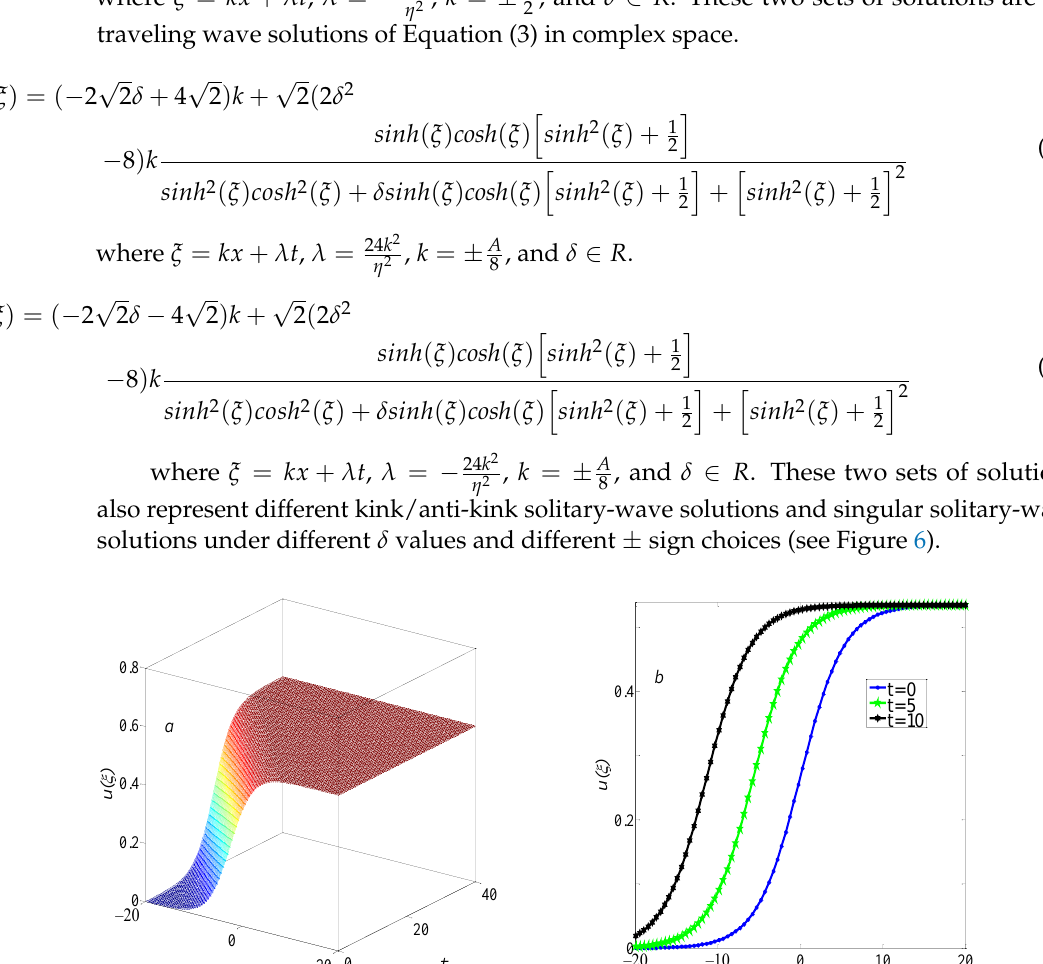
3𝑘 2 , 𝑘 = ±𝐴 , and 𝑟 ≠ 0 . 𝜂 2